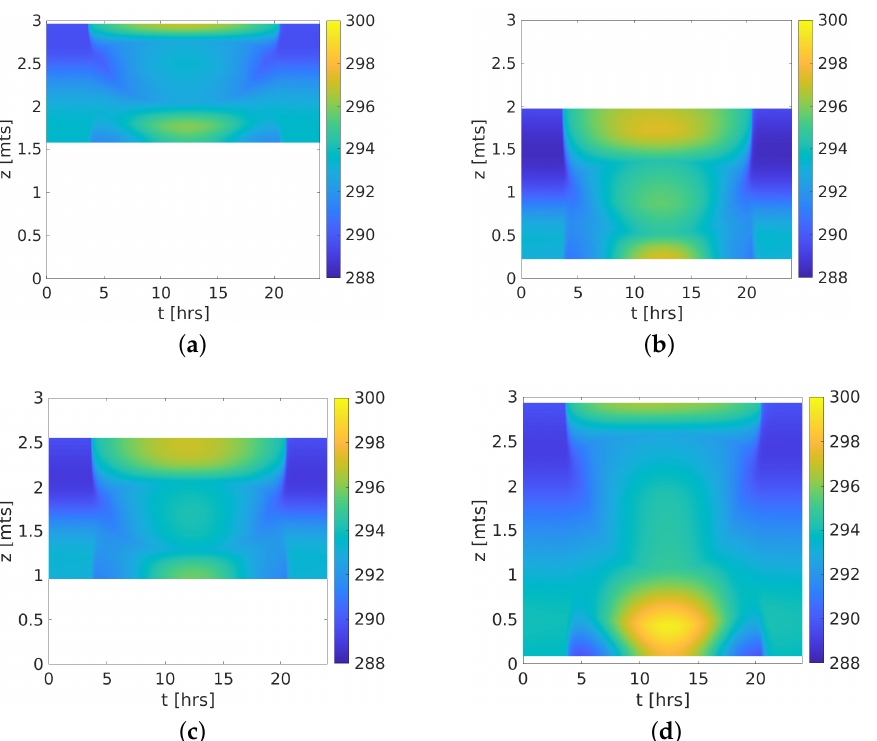
Figure 3. Leaf temperature variations at 24 h for all canopy shapes. ( a ) Case 1; ( b ) Case 2; ( c ) Case 3; ( d ) Case